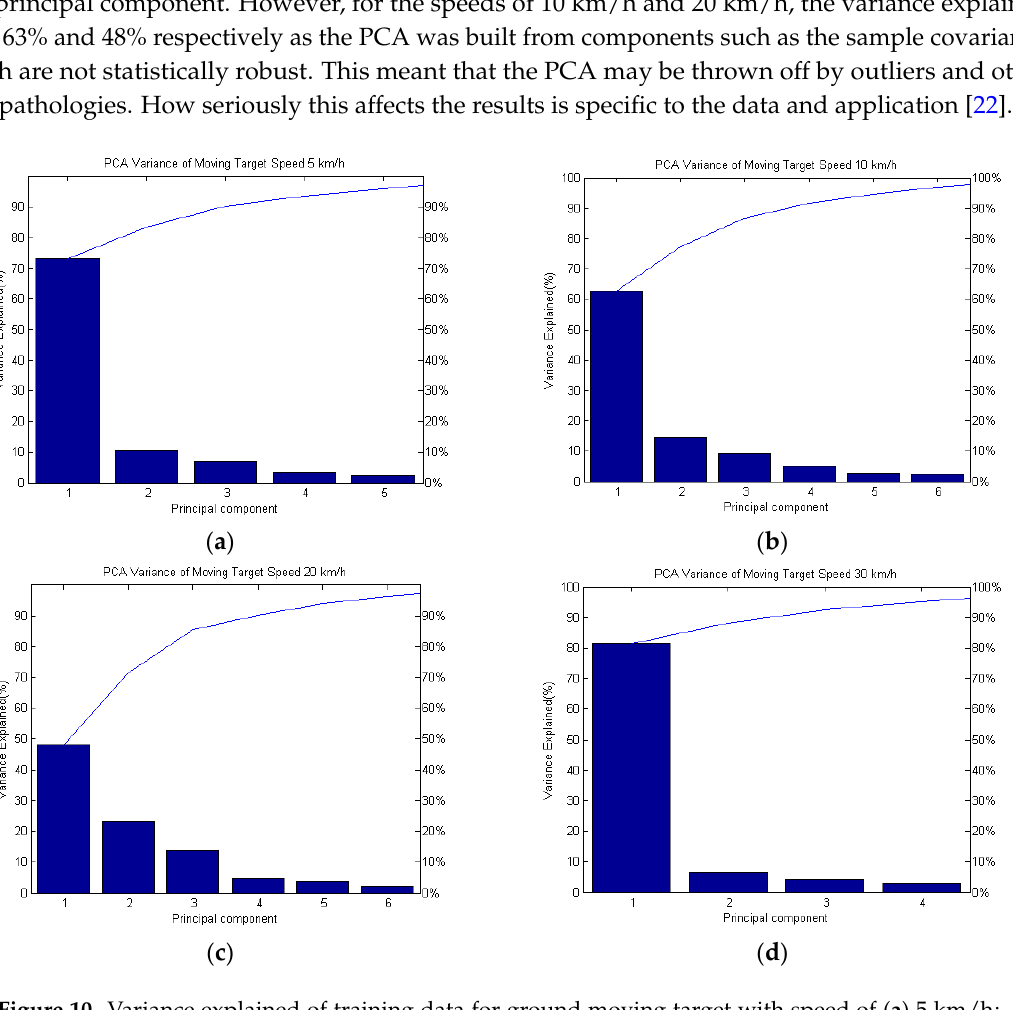
Figure 10. Variance explained of training data for ground moving target with speed of ( a ) 5 km/h; ( b ) 10 km/h; ( c ) 20 km/h and ( d ) 30 km/h in the PC space. Table 4. Experimental Results of Variance Training Data.